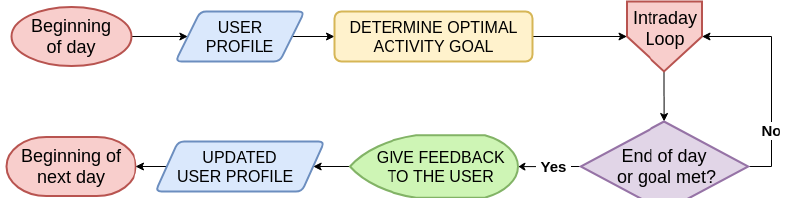
Figure 4. Adaptive System for Physical Activity: Support Phase—Daily Time Scale. After the initial learning phase, we know the user’s activity patterns, as well as physical health, personality, and context that compose the user profile. Hence, we are able to determine an optimal challenge point for the current user day based on his/her profile before monitoring the progress in separate intraday loops.